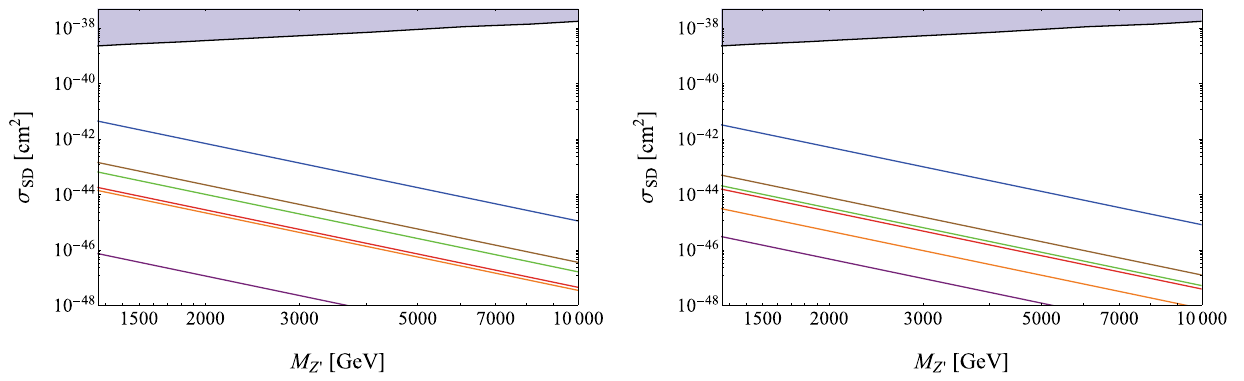
blackcurvereferstothe90%C.L.upperlimitsfromXENON100exper- iment. Left panel: z 1 = 1 / 4 and z 2 = 1 / 8. Right panel: z 1 = 1 / 5 and